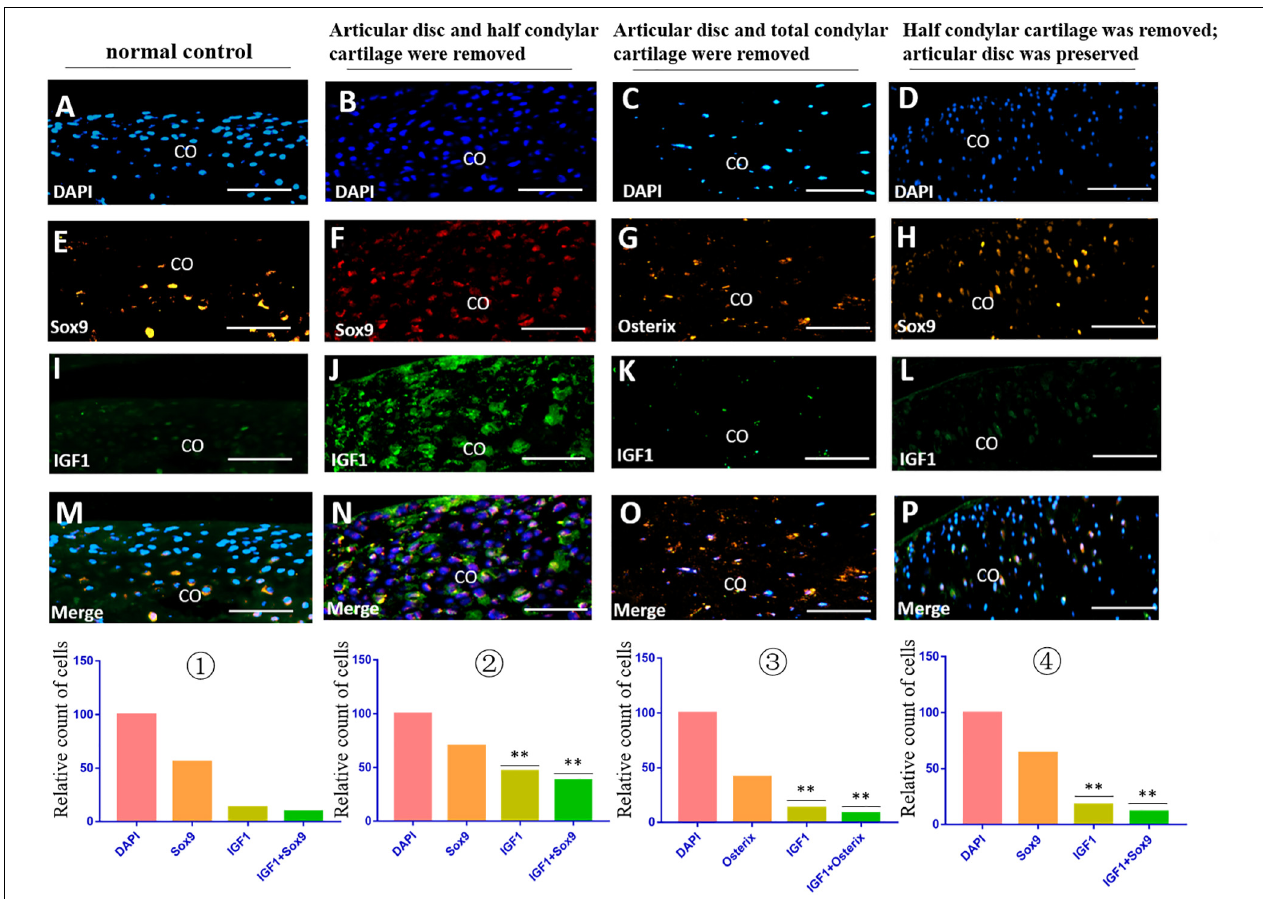
FIGURE 5 | IGF1/Sox9 and IGF1/Osterix immunofluorescence double staining in the TMJ in different animal models. (A–D) DAPI staining. (E,F,H) Sox9 staining. (G) Osterix staining. (I–L) IGF1 staining. (M–P) Merged image of DAPI, Sox9/Osterix, and IGF1 staining. (cid:172) The cell counts of different markers in the normal TMJ, with the count of DAPI accepted as 100 and the counts of other markers calculated and compared with the count of DAPI. (cid:173) The relative counts of IGF1-positive cells and costained cells were higher in the injured condylar cartilage in the first animal model than those in the normal TMJ ( ∗∗ p < 0.01). (cid:174) The relative counts of IGF1-positive cells and costained cells were lower in the injured subchondral bone in the second animal model than those in the first animal model ( ∗∗ p < 0.01). (cid:175) The relative counts of IGF1-positive cells and costained cells were also lower in the injured condylar cartilage in the third animal model than those in the first animal model ( ∗∗ p < 0.01). AD, articular disc; CO, condyle. Scale bar: 50 µ